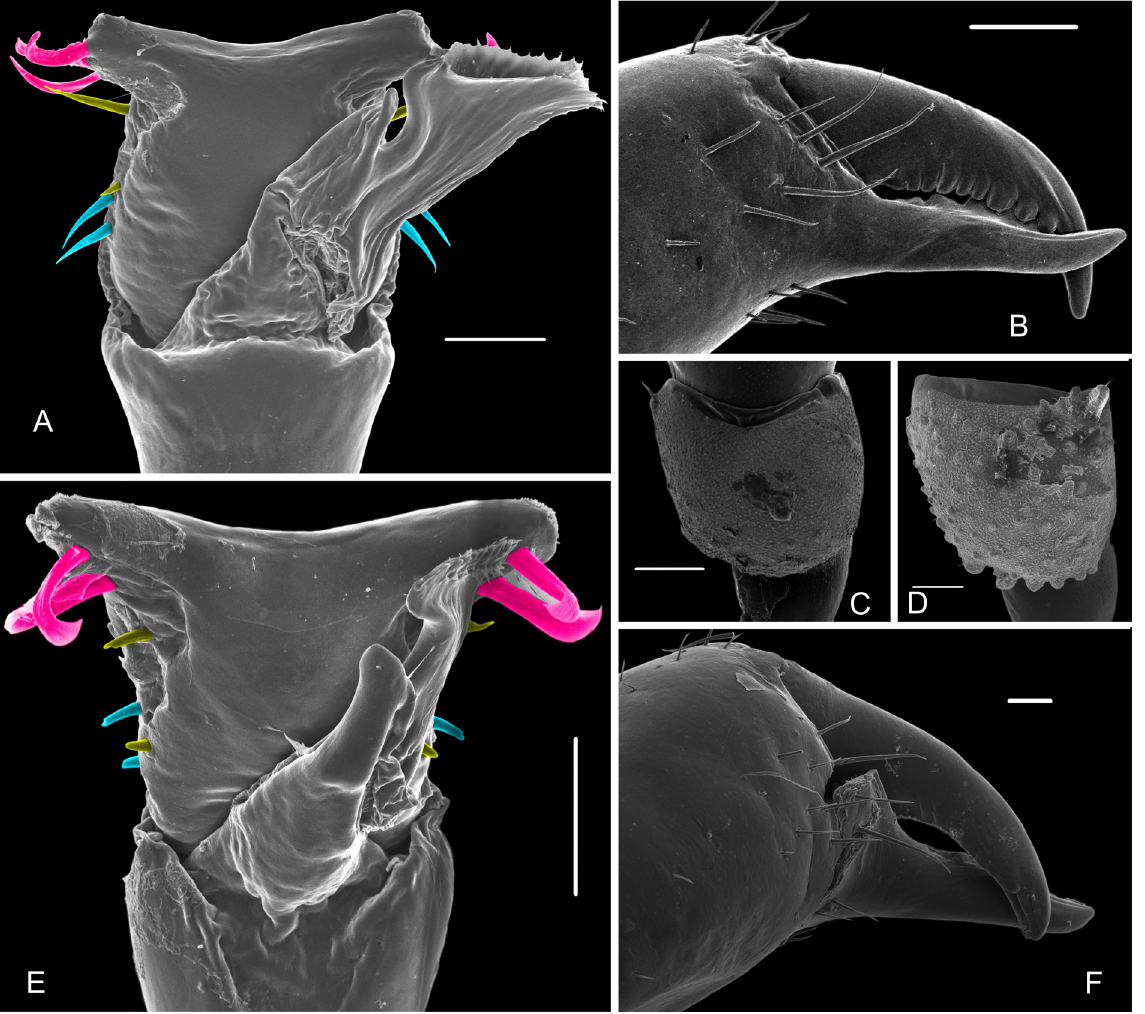
Fig. 4. Structures of presumed related species. – Libitia cordata (Gervais, 1844). A . Distal part of the penis, dorsal view (ICN-AO 413). B . Fingers of the hand of left chelicera (ICN-AO 1040). C . Left basichelicerite, dorsal view (ICN-AO 1040). – Ambatoiella vigilans Mello-Leitão, 1943. D . Left basichelicerite, dorsal view (MNRJ 2524). E . Distal part of the penis, dorsal view (MNRJ 19236). F . Fingers of the hand of left chelicera (MNRJ 2524). Macrosetae colors: fuchsia = MS C, yellow = MS D, aqua blue = MS A. Scale bars: A, E = 50µm; F = 100µm; B–D =